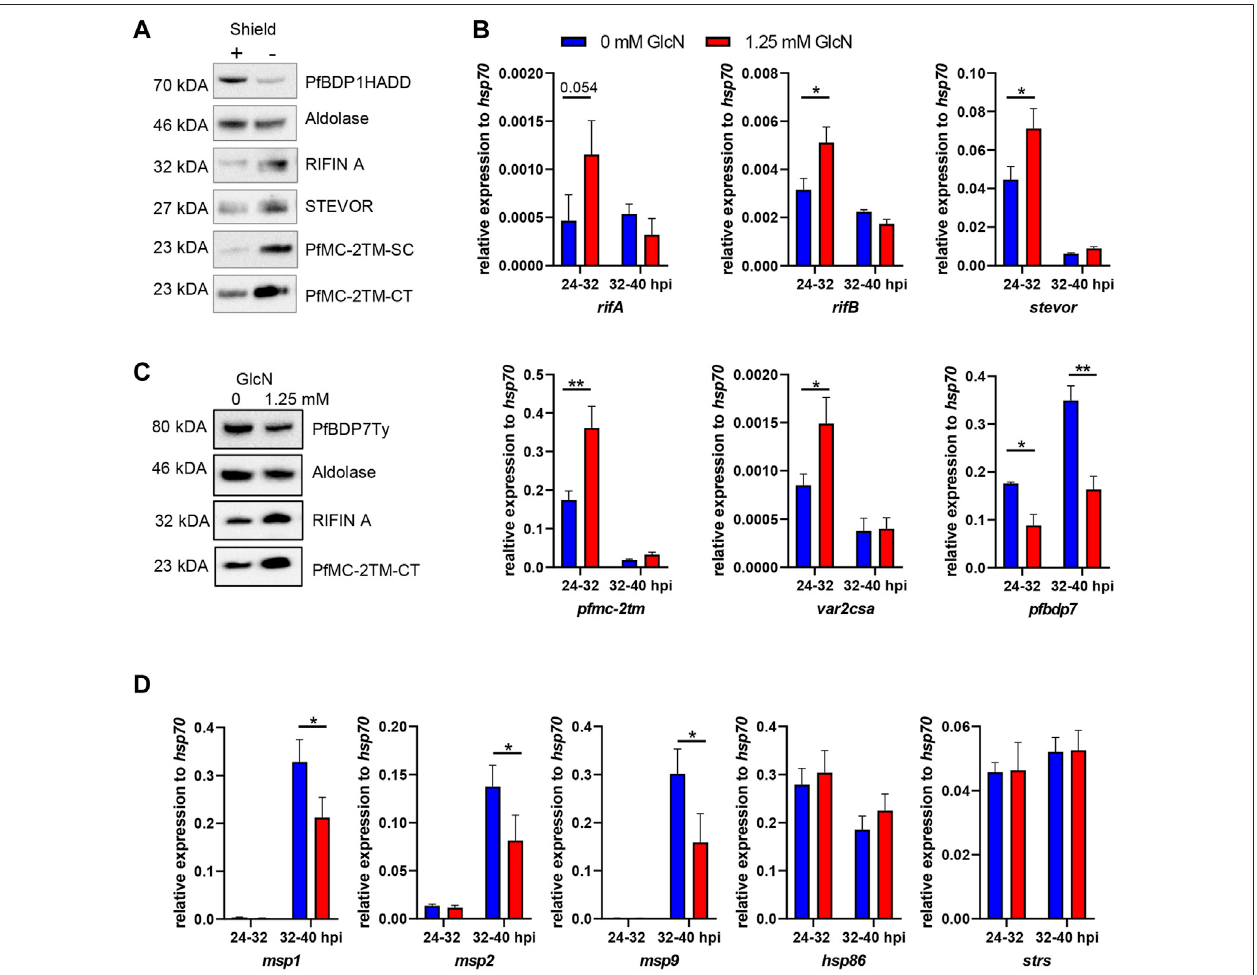
FIGURE 5 | Conditional depletion of PfBDP1 or PfBDP7 results in increased variant surface antigen expression and decreased invasion gene expression. (A) Western Blot of PfBDP1HADD trophozoite stage parasite lysates cultivated for 24 h in the presence (+, wt) or absence ( − , KD) of Shield1. Antibodies were directed against A-type RIFIN variant RIF40 (Petter et al., 2008), STEVOR variant PF3D7_0300400 (Bachmann et al., 2015); the semi-conserved (SC) or the C-terminus (CT) of PfMC-2TM(Bachmannetal.,2015).Onerepresentativeexampleof N =3biologicalreplicatesisshown. (B) qPCRanalysisofPfBDP7Ty_GlmSparasitescultivated with 0 or 1.25 mM glucosamine (GlcN) (mean and SD of N = 3). Glucosamine was added to synchronized ring stage parasites (0 – 8 hpi) and RNA was harvested in the next cycle at 24 – 32 hpi and 32 – 40 hpi. cDNA was quanti fi ed with degenerate primers amplifying conserved motifs in members of the, rifA , rifB , stevor , or